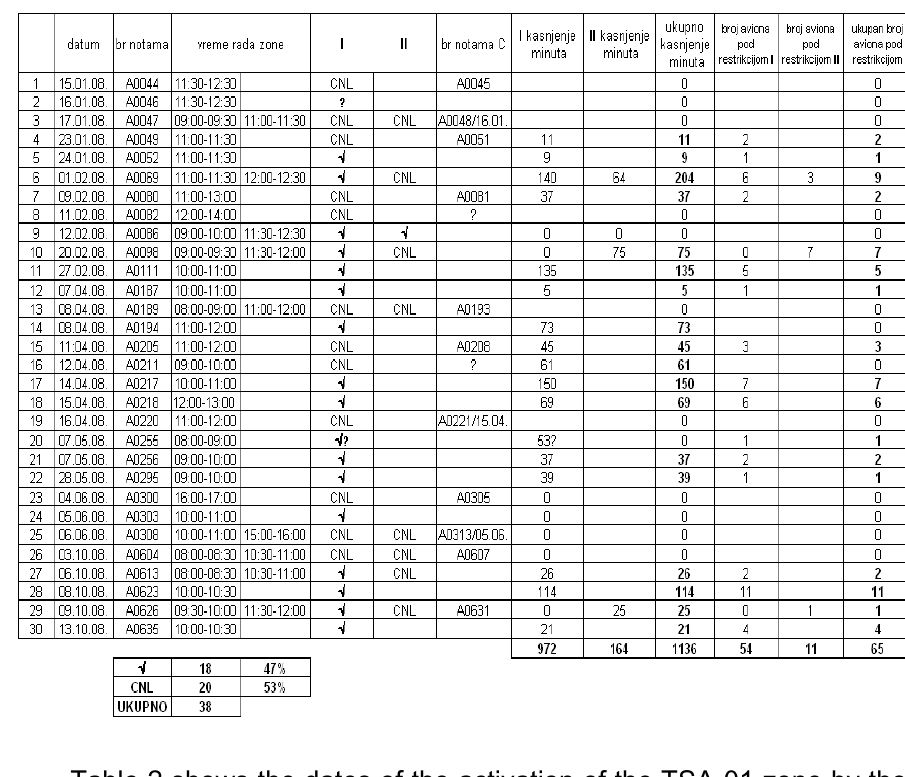
Табела 1 – Активация зоны TSA-01 (Pe č enkovi ć ,